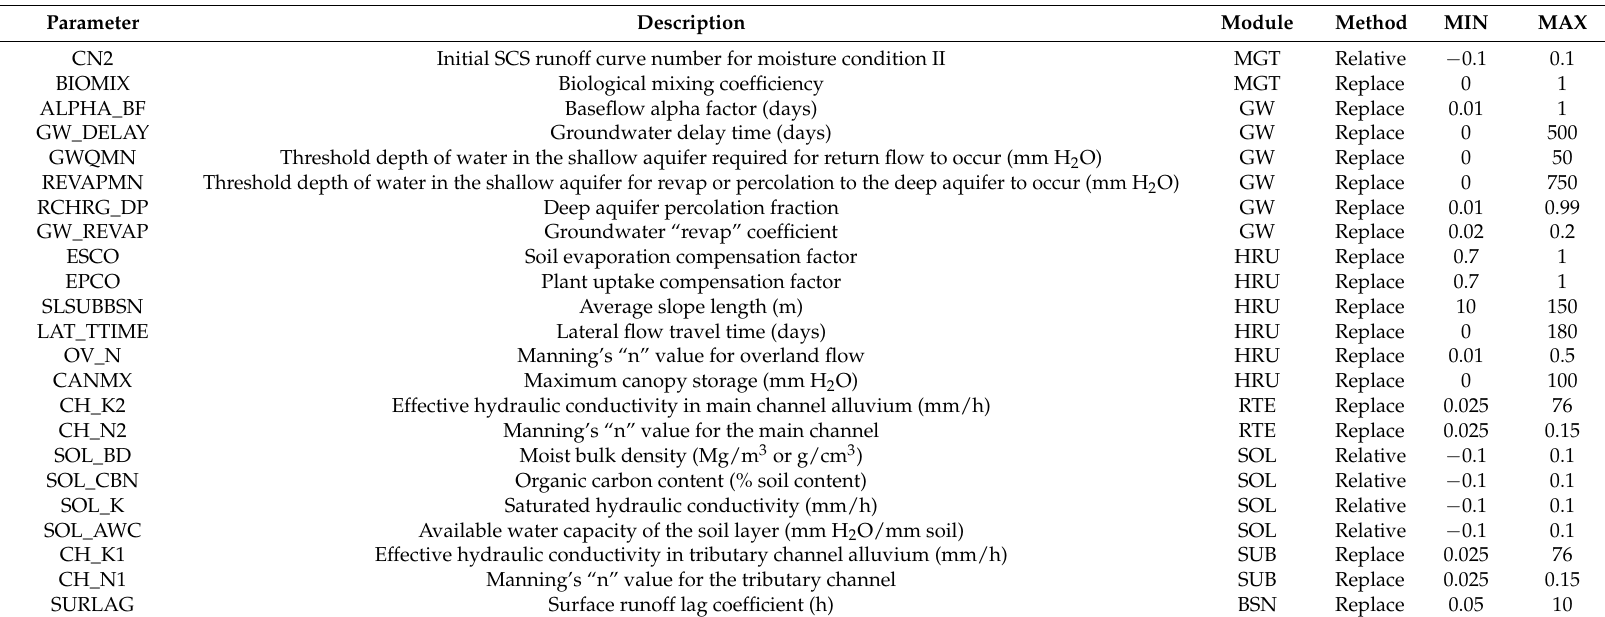
Table 2. Soil and Water Assessment Tool (SWAT) flowrate parameters for calibration and sensitivity